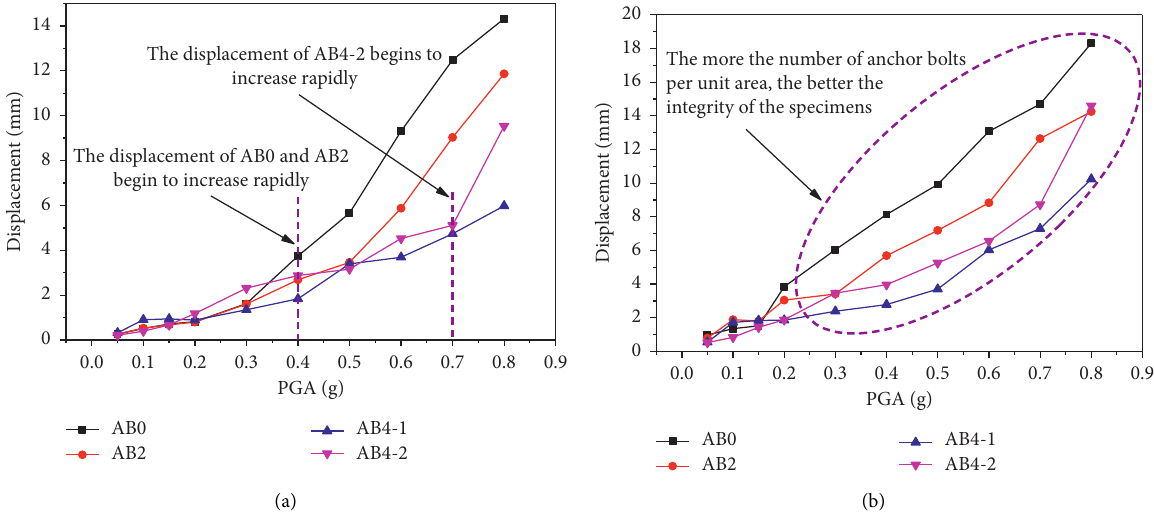
Figure 12: Displacement of IDB wall at different positions. (a) In the middle of the IDB wall. (b) At the top of the IDB